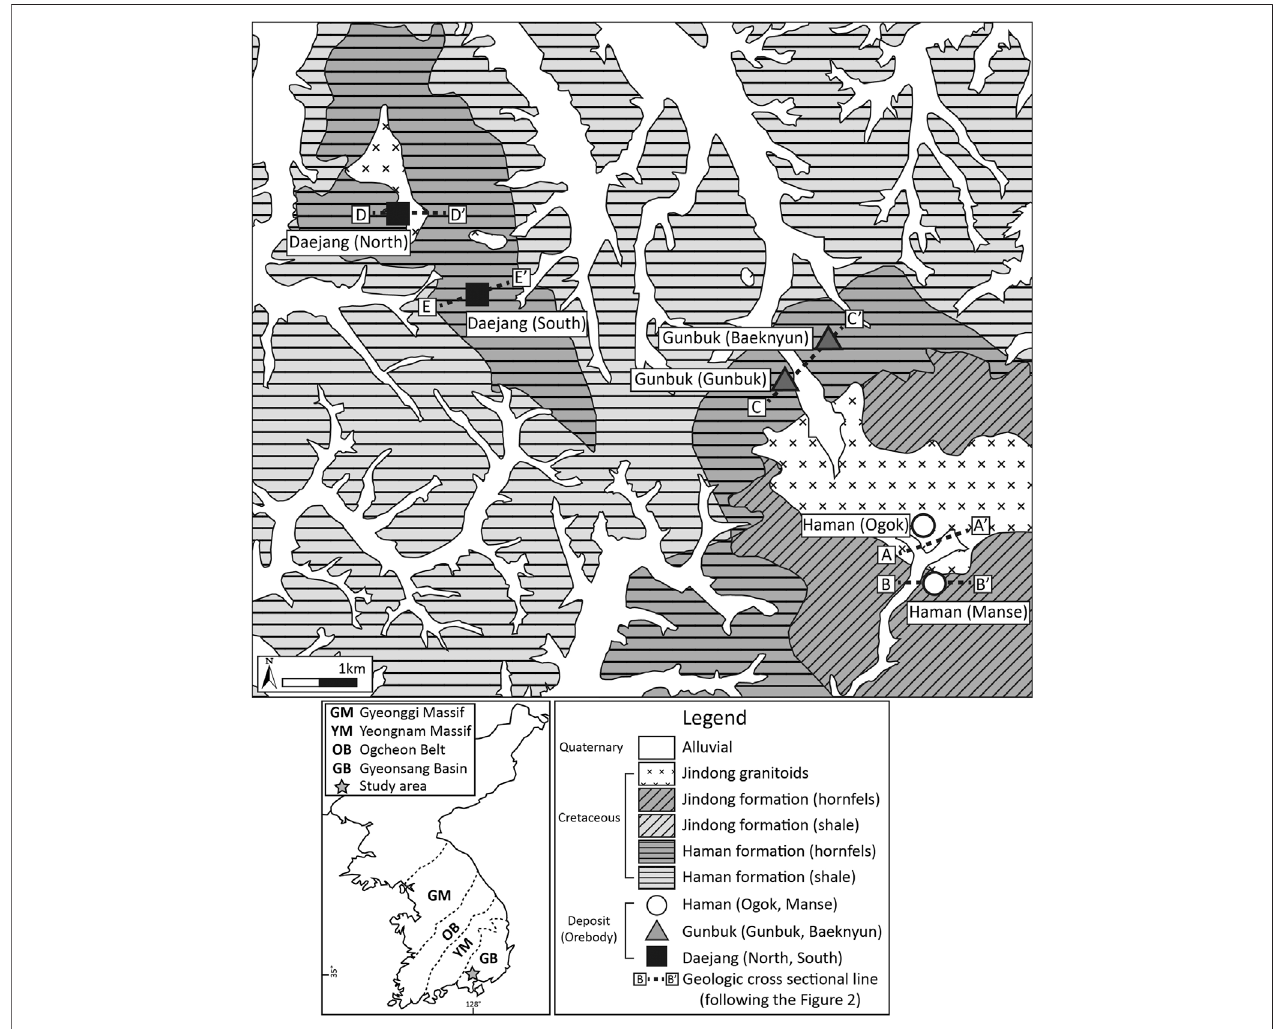
FIGURE 1 | Geological map of the Haman, Gunbuk, and Daejang deposits located in the Gyeongsang basin. The three deposits are hosted in the Cretaceous Haman-Jindong shale formation. The Haman-Jindong formation is widely metamorphosed into hornfels by an intrusion of Jindong granitoids. Geologic cross-sectional maps of the three deposits are shown in Figure 2